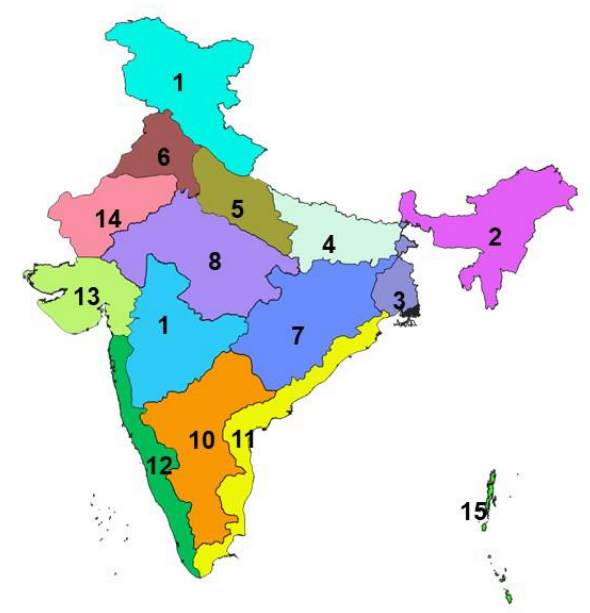
Figure 1. Shows different agro-climatic zones of India. 1.Western Himalayan 2. Eastern Himalayan 3. Lower Gangetic Plains 4. Middle Gangetic Plains 5. Upper Gangetic Plains 6. Trans Gangetic Plains 7. Eastern Plateau & Hills 8. Central Plateau & Hills 9. Western Plateau & Hills 10. Southern Plateau & Hills 11. East Coast Plains & Hills 12. West Coast Plains & Hills 13. Gujarat Plans and Hills 14. Western Dry Region and 15.